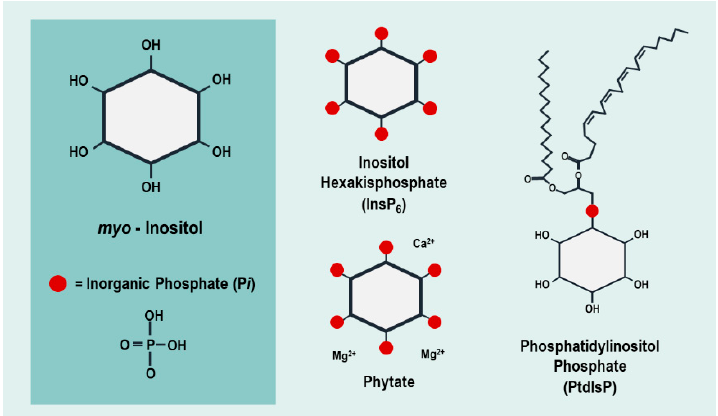
Figure 1. Simplified structures of myo -inositol, InsP 6 , phytate, and PtdInsP. Inorganic phosphate (P i ) groups, covalently bound to the myo -inositol ring by an oxygen molecule, are represented in red. For simplification purposes, this figure does not take into account the axial and equatorial positions of the moieties.